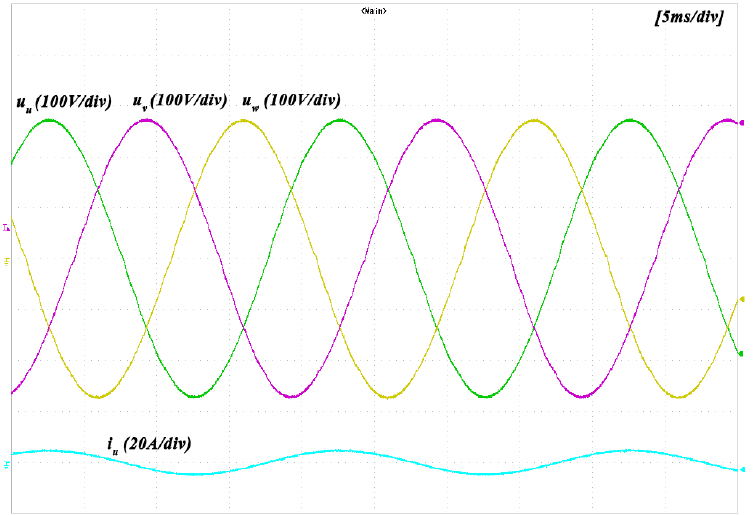
Figure 20. Phase-to-neutral voltages u u , u v , u w of the 3 Φ 5L E-Type MMI side under resistive load.